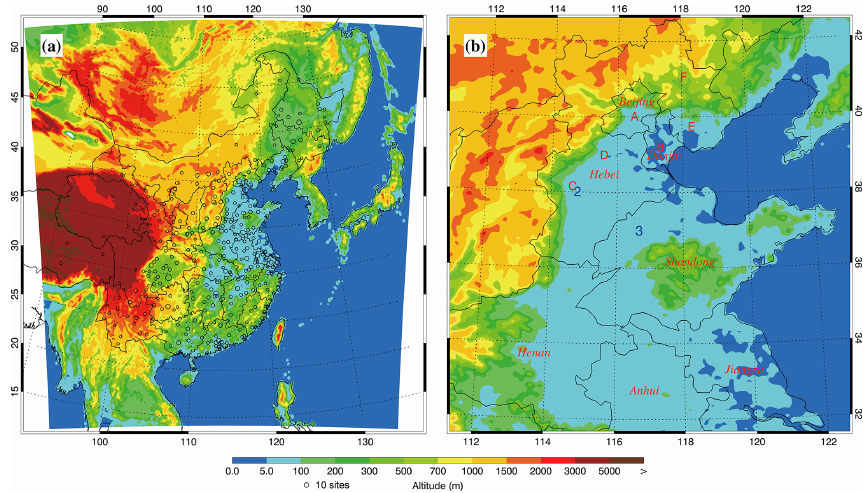
Figure 1. (a) WRF-Chem simulation domain with topography and (b) North China Plain. In (a) , the blue circles represent centers of cities with ambient monitoring sites, and the size of circles denotes the number of ambient monitoring sites of cities. In (b) , the red capitals denote six typical polluted cities in NCP: A is Beijing, B is Tianjin, C is Shijiazhuang, D is Baoding, E is Tangshan, and F is Chengde. The blue numbers denote the CERN sites with the hourly RH measurement: 1 is Jiaozhouwan, 2 is Yucheng, and 3 is Luancheng. Table 1. WRF-Chem Model